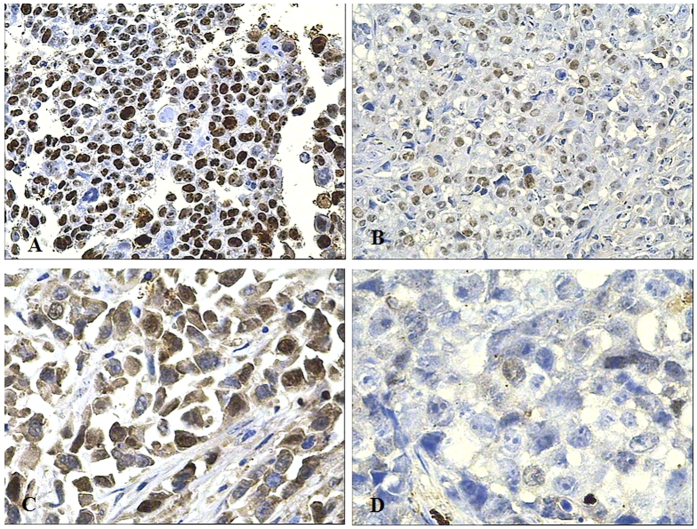
Ki67 and survivin protein expression in xenograft hepatoma tissue tested by IHC.(A) Ki67 of saline control group (200×); (B) Ki67 of nuclide-alone group (200×); (C) survivin of saline control group (400×); (D) Survivin of nuclide-alone group (400×).